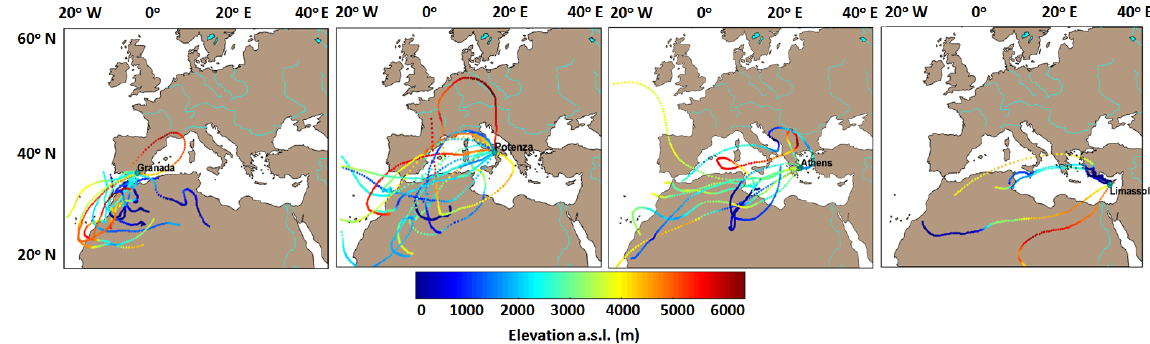
Figure 1. 96–120h backward trajectories for air masses arriving over (a) Granada, (b) Potenza, (c) Athens and (d) Limassol, for arrival heights of approximately the center of each observed dust layer (51 cases in the period